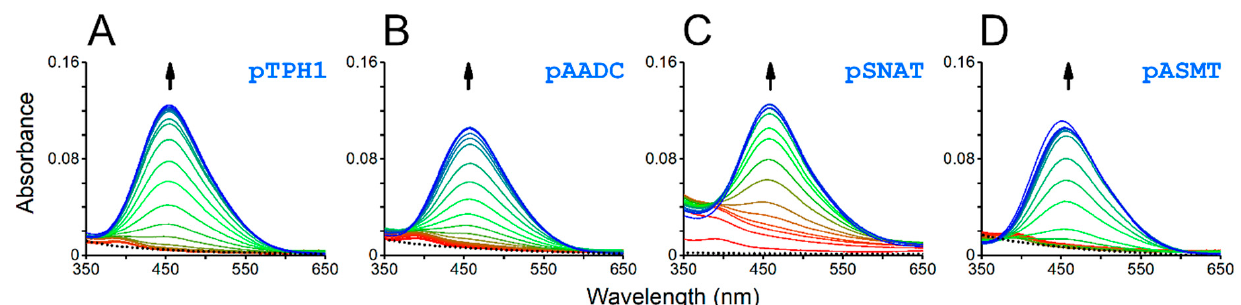
Figure 3. UV-vis spectra of 0.95:1.00 mixtures of Ni(II) ions with the respective peptides, pTPH1 ( A ), pAADC ( B ), pSNAT ( C ), and pASMT ( D ), obtained for different pH values, starting from 3.5 (red) to 10.5 (blue). The spectra for apopeptides are represented by black dotted lines (near zero absorbance). The arrows mark the pH-dependent appearance of the d-d band characteristic for hydrolytic square planar 4N Ni(II) complexes.